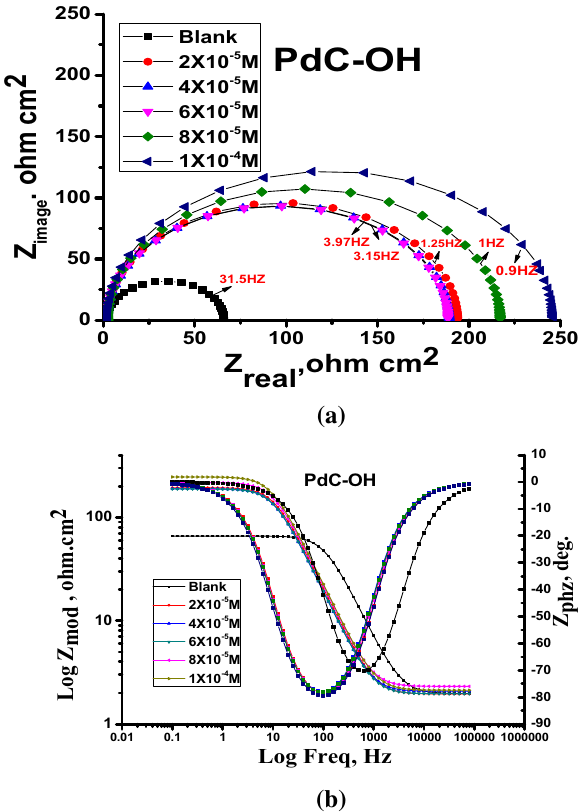
Figure 8. Nyquist ( a ) and Bode-phase angle ( b ) plots for corrosion of carbon steel in 1 M HCl in the absence and presence of various concentrations of PdC-OH at 25 °C.